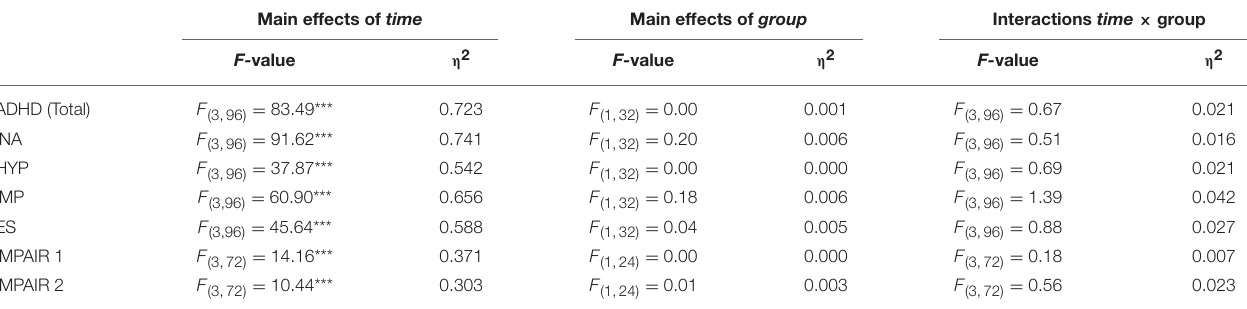
TABLE 4 | ANOVAs of ADHD symptom and impairment level changes between the two treatment groups.